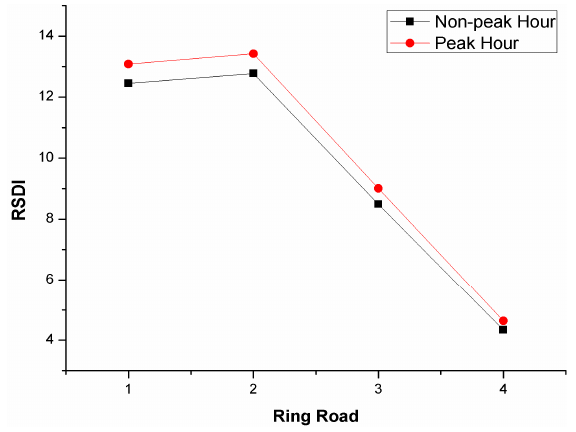
Figure 12. Average RSDI of the ring area.